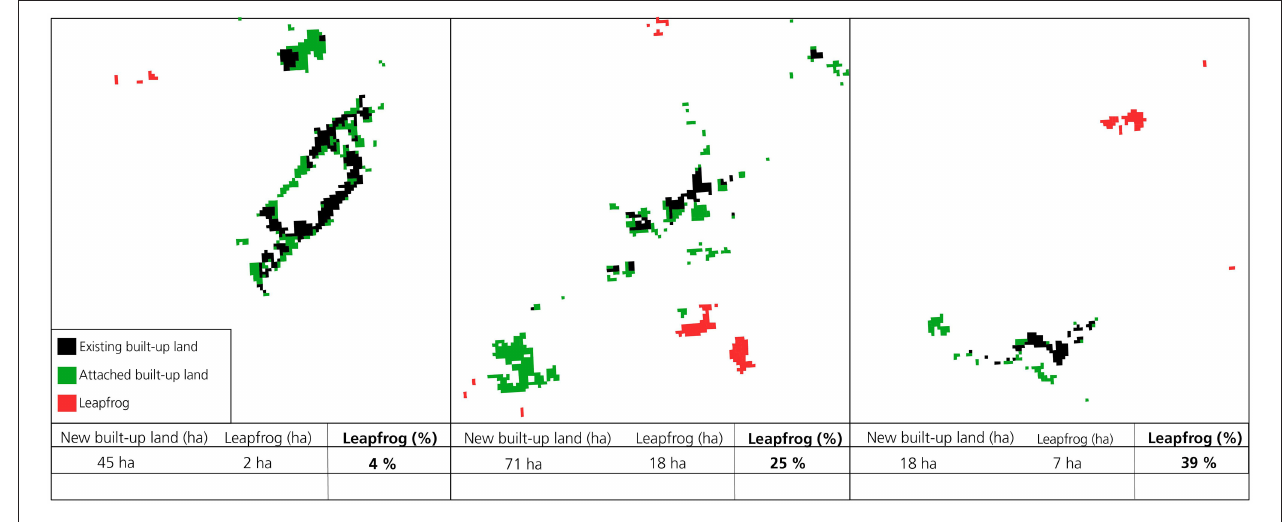
FIGURE 2 | Examples of built-up area compositions and share of leapfrog.